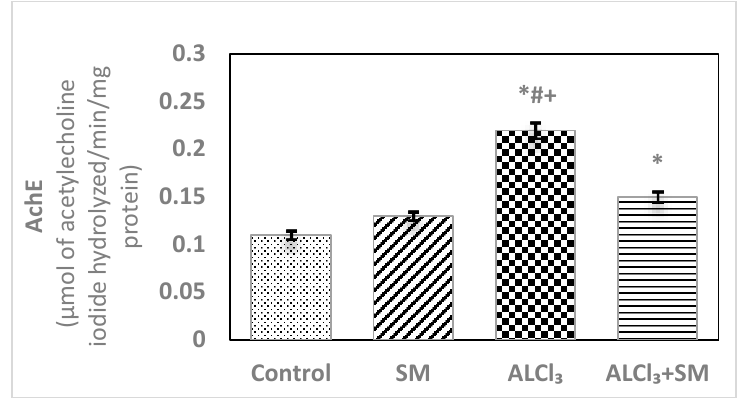
02468 *#+ Figure 1. Levels of ( a ) malondialdehyde (MDA), ( b ) nitric oxide (NO) and ( c ) reduced glutathione (GSH), and activities of ( d ) superoxide dismutase (SOD) and ( e ) catalase (CAT) in hippocampal tissues of control and experimental groups of rats. Values are expressed as mean ± standard error of mean (SEM) ( n = 6). Comparisons are as follows: * p ≤ 0.05, significantly different from Control; # p ≤ 0.05, significantly different from silymarin (SM); + p ≤ 0.05, AlCl 3 significantly different from AlCl 3 + SM group. Figure 2. Levels of the proinflammatory cytokines ( a ) tumor necrosis factor-alpha (TNF- α ) and ( b ) interleukin-1beta (IL-1 β ) in hippocampal tissues of control and experimental groups of rats. Values are expressed as mean ± SEM ( n = 6). Comparisons are as follows: * p ≤ 0.05, significantly different from Control; # p ≤ 0.05, significantly different from SM; + p ≤ 0.05, AlCl 3 significantly different from AlCl 3 + SM group. Figure 3. Levels of acetylcholinesterase (AChE) in hippocampal tissues of control and experimental groups of rats. Values are expressed as mean ± SEM (n = 6). Comparisons are as follows: * p ≤ 0.05, significantly different from Control; # p ≤ 0.05, significantly different from SM; + p ≤ 0.05, AlCl 3 significantly different from AlCl 3 + SM group.